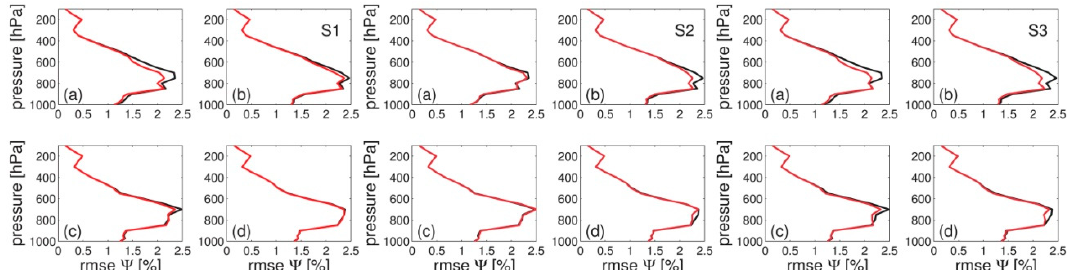
Figure 11. The root mean square error of the background (analysis) refractivity in percent as a function of the pressure in black (red). Left panel: ZTDs are assimilated. Middle panel: horizontal delay gradients are assimilated. Right panel: ZTDs and Horizontal delay gradients are assimilated. In each panel the four plots correspond to the grid points surrounding the station Potsdam. The labels (a), (b), (c) and (d) correspond to the grid points to the north-west, north-east, south-west and south-east respectively. GNSS ZTDs and horizontal delay gradients from the G-Nut/Tefnut software for the single station Potsdam are assimilated four times per day (0, 6, 12, 18 UTC) for a period of two months (June and July,